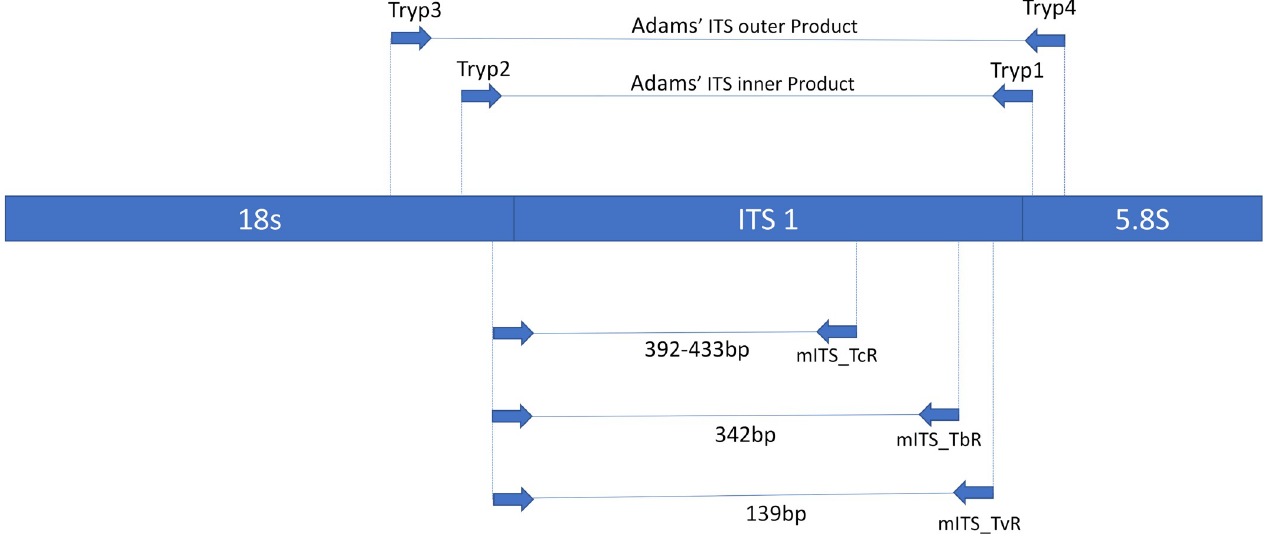
Fig 2. Diagrammatic representation of the location of the multiplex ITS primers in relation to the universal primers designed by Adams et. al. (2006) on the ribosomal DNA.